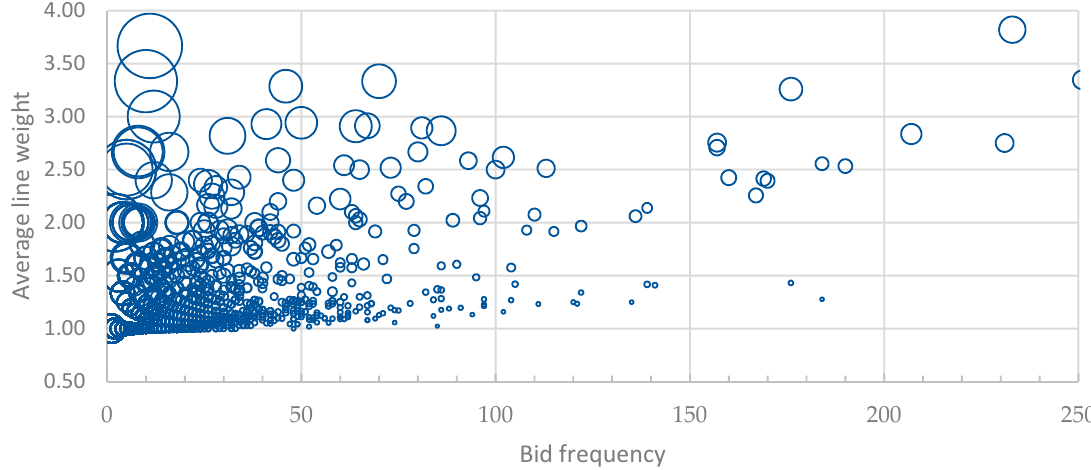
Figure 3. Bid frequency, average line weight, and discrete coefficient.